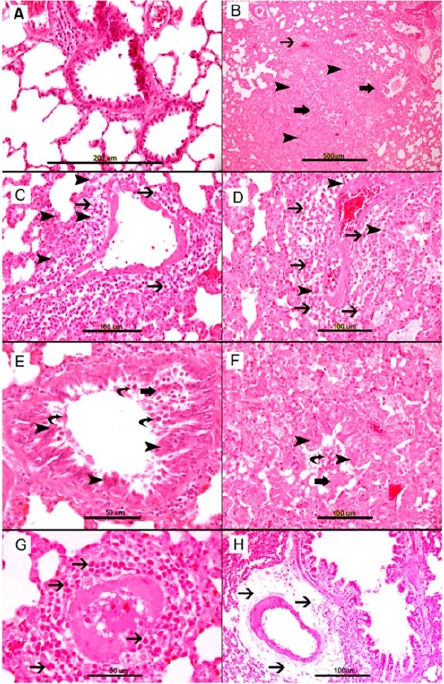
Figure 1. Representative sections of lung tissue. ( A ) Control group, showing lung tissue with patent alveolar spaces and bronchial passages and unremarkable blood vessels. ( B – H ) show anaphylactic changes in the lung. ( B ) Heavy mixed inflammatory cell infiltration of lung parenchyma with widening of interalveolar spaces (arrowheads), perivascular cellular infiltrates (thin arrows) and peribronchial inflammation (thick arrows). ( C , D ) Perivascular edema and heavy inflammatory cell infiltrate consisting predominantly of mast cells (thin arrows) and eosinophils (arrowheads). ( E , F ) Narrowing of the bronchial lumen with sloughing of respiratory epithelium (thick arrow), epithelial injury (arrowhead) and fallen dead cells in the lumen (curved arrow). ( G ) Heavy perivascular eosinophil infiltration (thin arrow). ( H ) Severe perivascular edema (thin arrow). This figure with explanatory text is obtained from an open access article distributed under the Creative Commons Attribution License which permits unrestricted use, distribution and reproduction in any medium, provided the original work is properly cited [8].